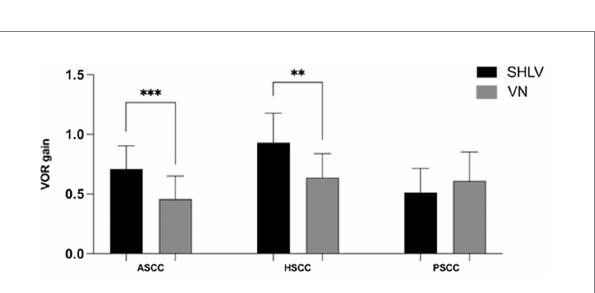
FIGURE 4 Comparison between the vHIT gain in anterior semicircular canal (ASCC), horizontal semicircular canal (HSCC) and posterior semicircular canal (PSCC) on the affected sides in SHLV patients and VN patients. ** p < 0.01, *** p < 0.001.